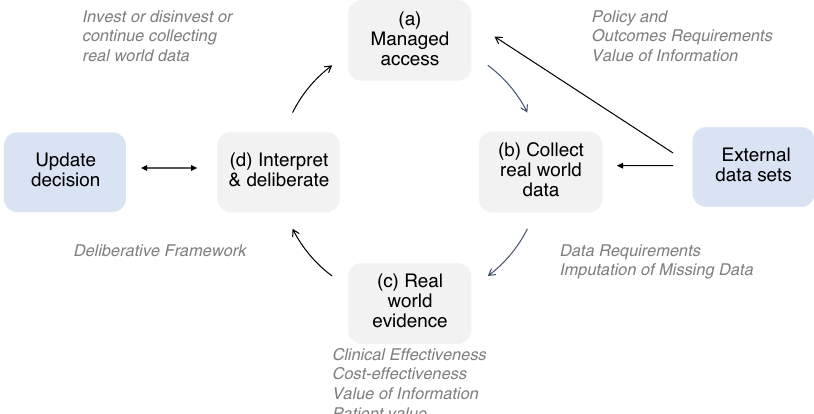
Fig. 2 A life-cycle health technology assessment process framework. Life-cycle health technology assessment is the standardization of data collected and methods needed to inform life-cycle appraisal, re-appraisal, and de-adoption of health technologies. The framework includes: managed access for conditional support subject to collecting real world evidence; collecting real world data and concatenating that data with external data; generating real world evidence for decisions, and interpreting the evidence to decide on adoption, disinvesting from managed access, or continuing to collect data.